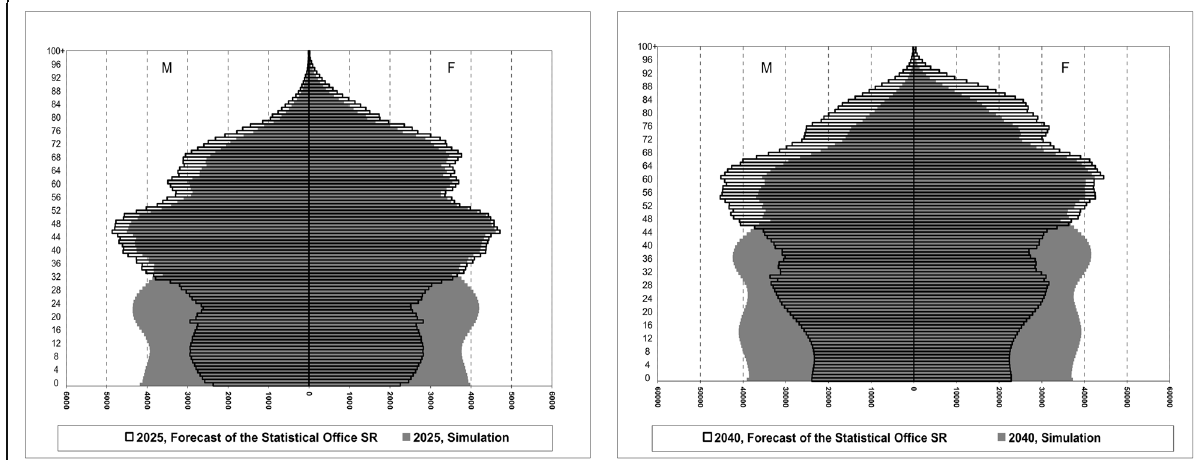
Fig. 7 Age structure of the Slovak Republic — simulation versus official forecast. Source: [19], authors ’